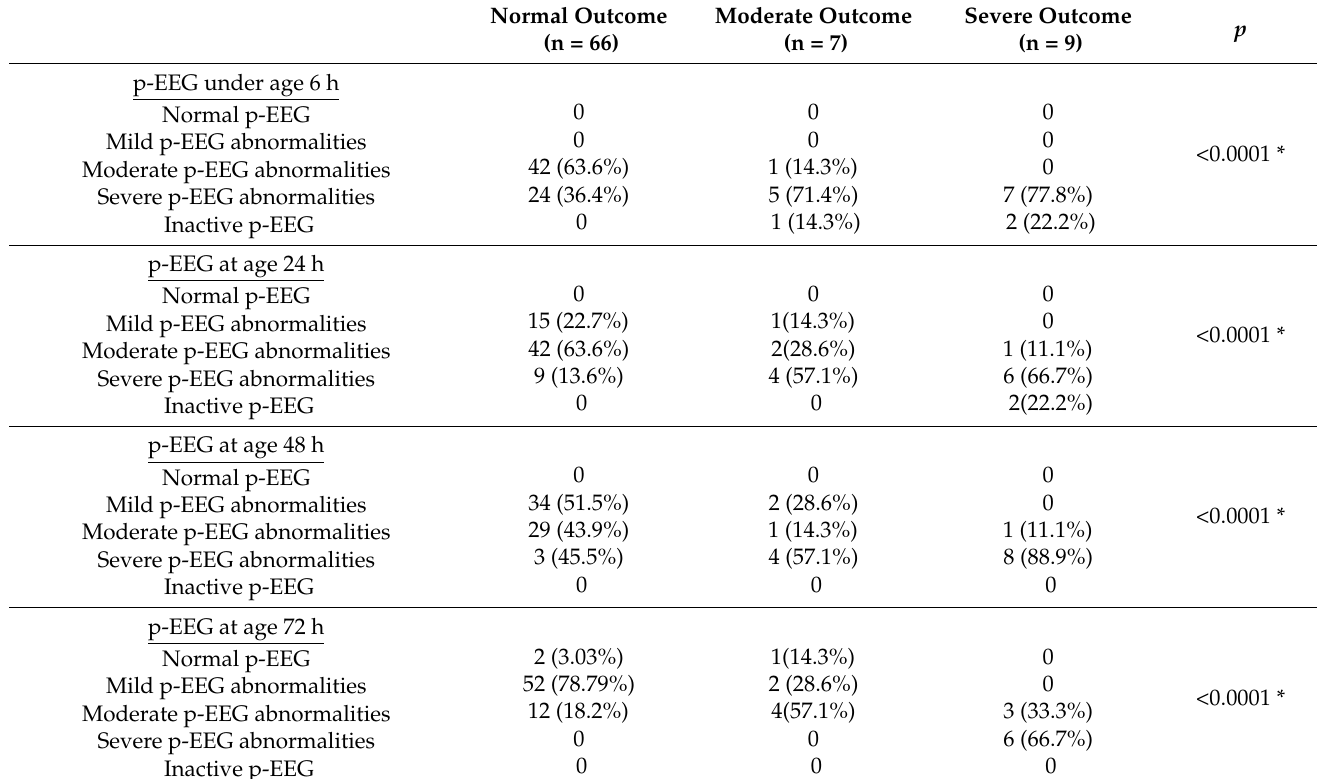
Table 3. p-EEG in patients with normal, moderate, and severe neurodevelopmental outcome.